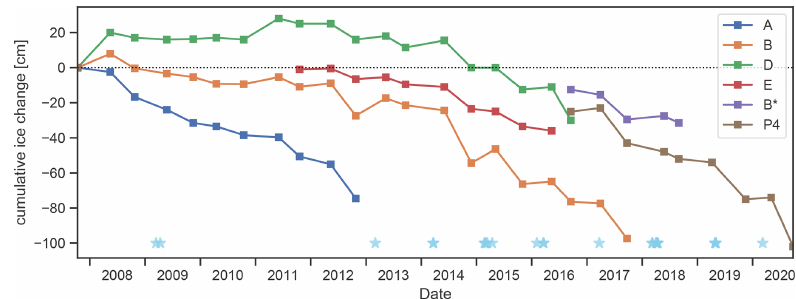
Figure 10. Cumulative ice height change at different stakes and along the path (P4) in HIC starting from 12 October 2007. Light-blue stars below mark days when shovelling of snow into the cave was documented.